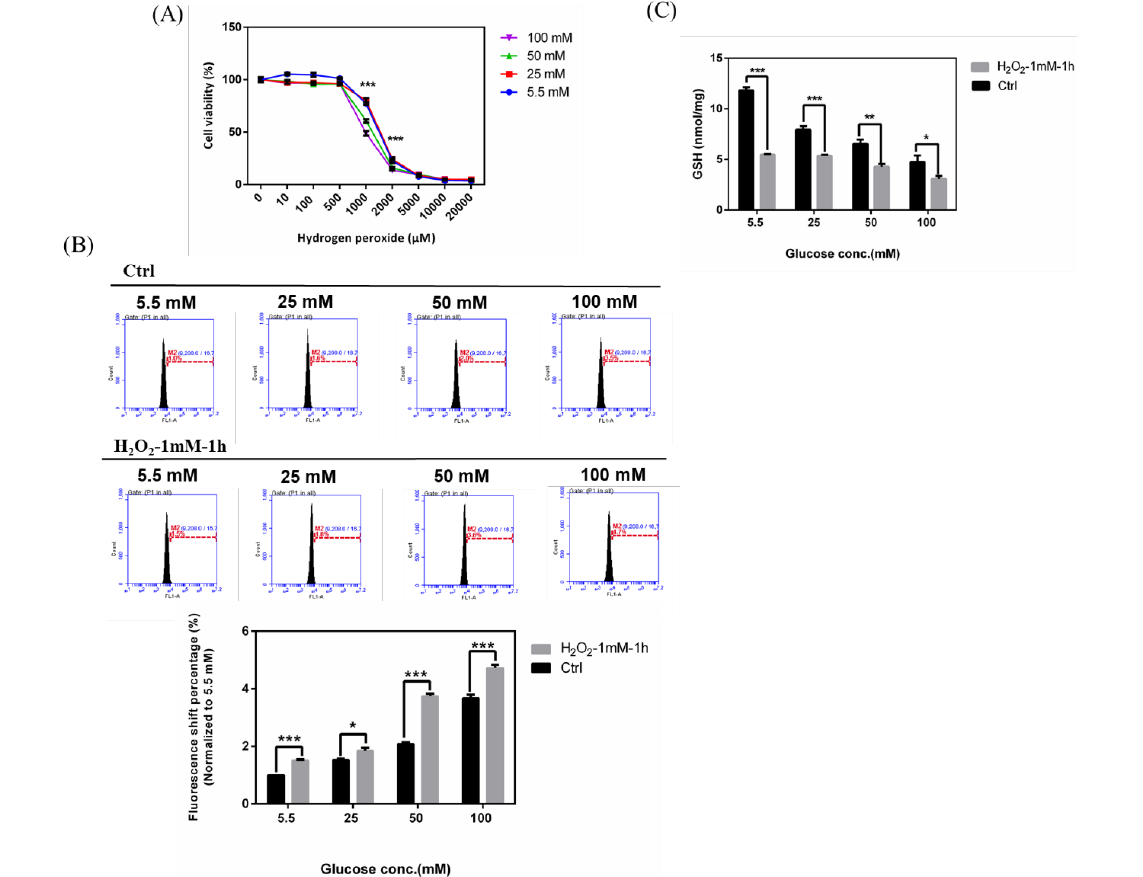
Figure 8. Effects in RGCs with hyperglycemia with or w/o hydrogen peroxide for 1 h. ( A ) RGC-5 cells were incubated in 5.5 mM, 25 mM, 50 mM, and 100 mM glucose for long-term exposure and seeded into 96-well plates to treat with different concentrations of H 2 O 2 . Cell viability under different concentrations for 1 h was evaluated using the cell viability assay. ***, p < 0.001 when compared to the 5.5 mM group. ( B ) Upper: iROS accumulation measurement in RGCs with hyperglycemia with or w/o hydrogen peroxide (1 mM) for 1 h. Intracellular ROS accumulations were quantified by the APF assay